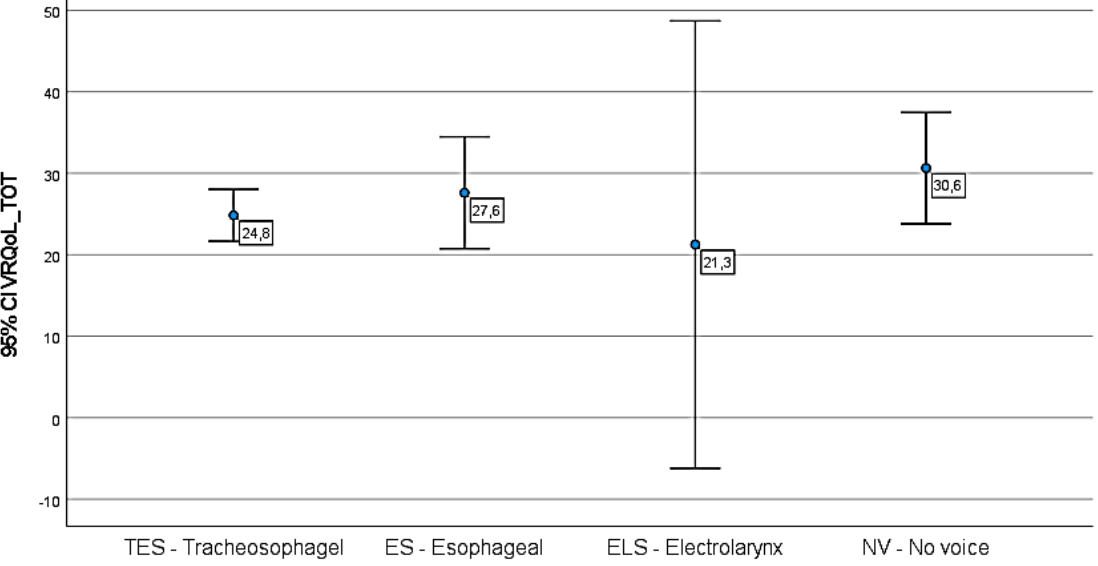
Figure 1. VRQoL self- assessment, circle represents the mean, bars represent 95% CIs, labels report the mean. Score range: 10–15 excellent, 16–20 very good, 21–25 good, 26–30 quite good, above 30 low.